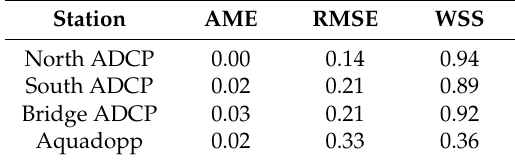
Table 4. Salish Sea model calibration error statistics and skill score for velocities.